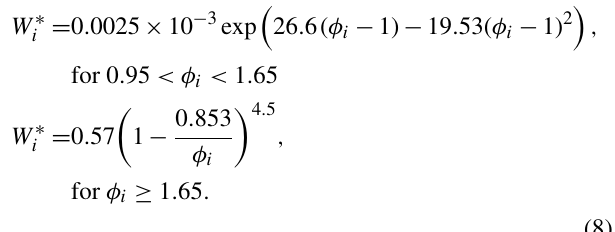
(cid:16) 26 . 6( φ i − 1) − 19 . 53( φ i − 1) 2